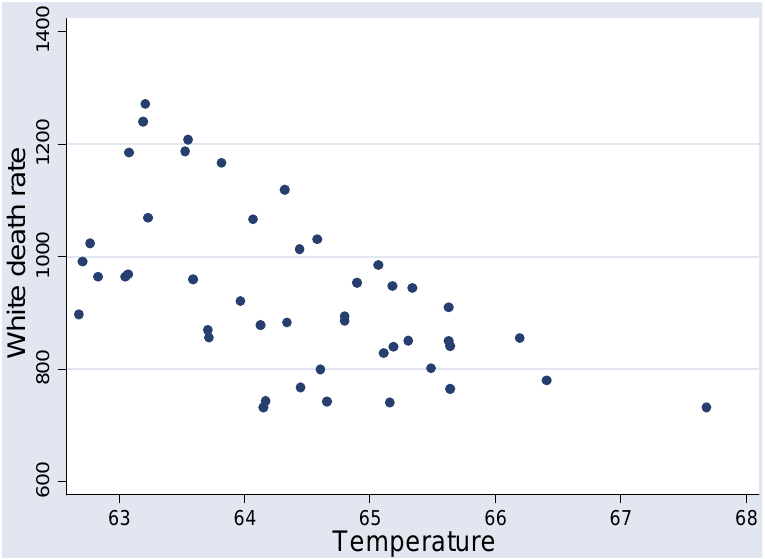
Figure 2. Yearly temperatures vs. yearly white age-adjusted death rates in the continental U.S.,